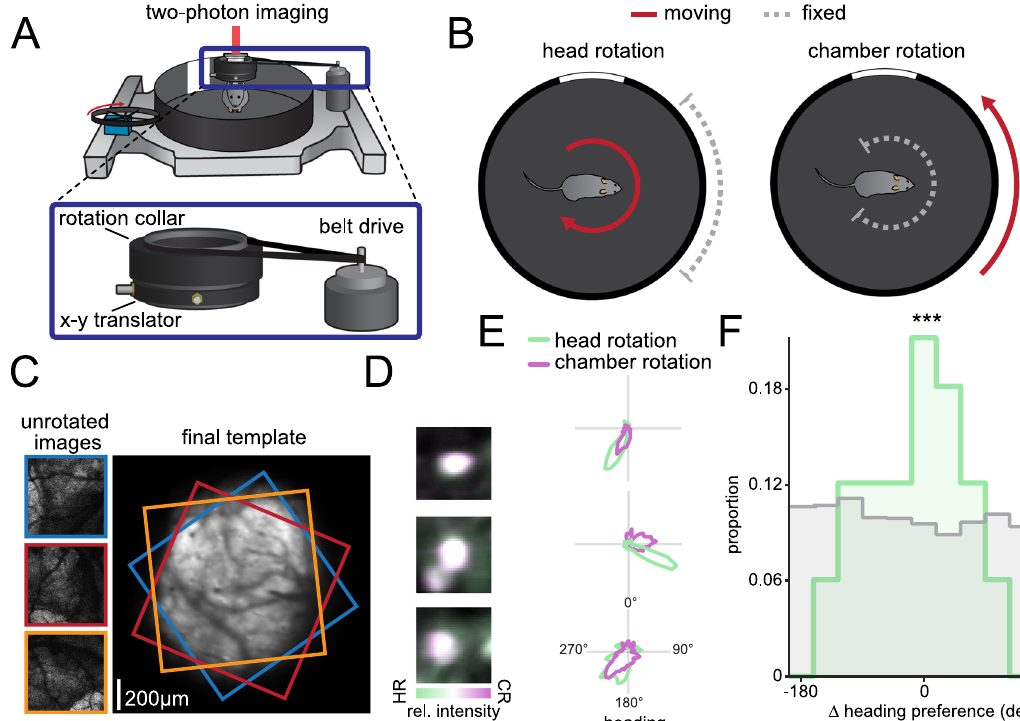
individual image. The fi nal template shown on the right isafter all the images have been registered for the recording ( n =5 imaging fi elds over 4 mice). D Example of three matched ROIs from the recordings. Purple denotes greater brightness in the chamberrotationrecording,whereasgreendenotesgreaterbrightnessinthehead- rotation recording. White denotes equal brightness and suggests good alignment oftheROIsacrossrecordings.HR:Headingrotation,CR:chamberrotation. E Three example tuning curves from pairs of ROIs showing similar tuning preferences. The tuning curve in the head rotation condition is shown in green, whereas the tuning curve in the chamber rotation condition is shown in purple. F Histogram showing thedifferenceinpeakheadingpreferenceacrossrecordingsformatchedROIs.The zero-centered peak in the data (green) indicates that cells remained tuned to the similar heading angles independent of head- or chamber-rotation. Shuf fl ed dis- tribution is shown in gray. *** p =2.5×10 − 4 , V-test for circular nonuniformity against